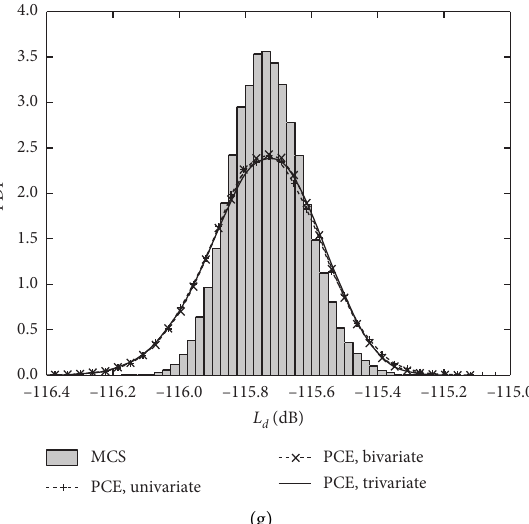
Figure 6: PDFs of the dynamic compliance amplitude within 29 ∼ 35 Hz. (a) 29 Hz. (b) 30 Hz. (c) 31Hz. (d) 32Hz. (e) 33Hz. (f) 34Hz. (g) 35Hz.